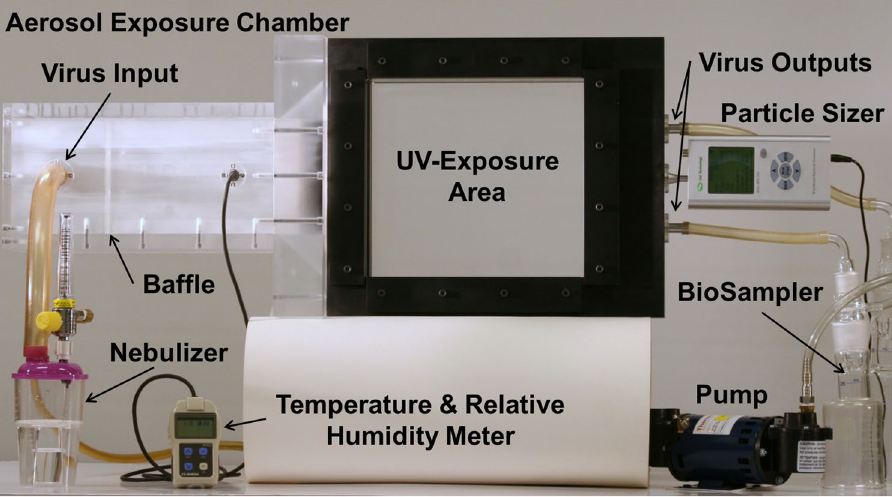
Figure 4. Photograph of the custom UV irradiation chamber. The experimental setup shows many of the necessary components while some elements, such as pumps, filters, and lamps, were omitted to better depict the overall setup.